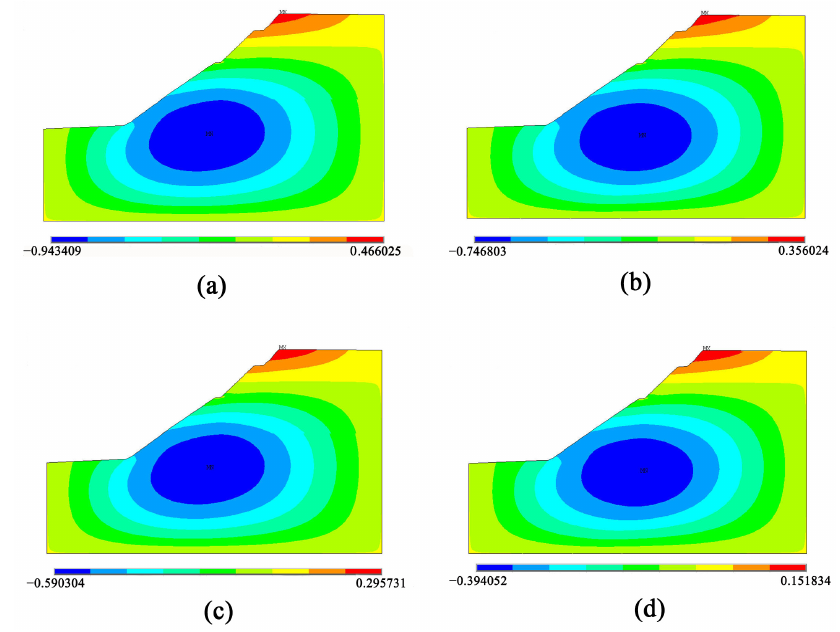
Figure 8. X-direction displacement diagrams at the top of the slope, where the unit is m. ( a ) Working condition V; ( b ) Working condition VI; ( c ) Working condition VII; ( d ) Working condition VIII.